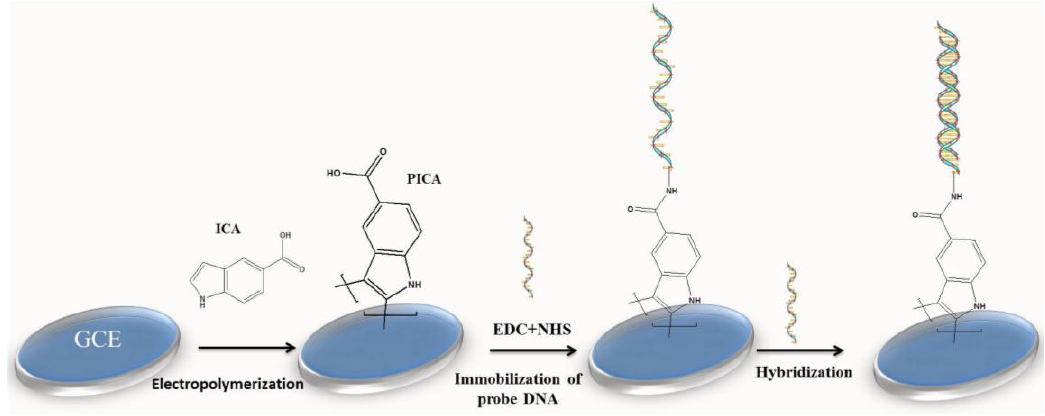
Figure 7. Schematic representation of the preparation of an electrochemical DNA sensor based on a poly(indole-5-carboxylic acid) (PICA) conducting polymer. (Redrawn from [187]. Copyright 2014,